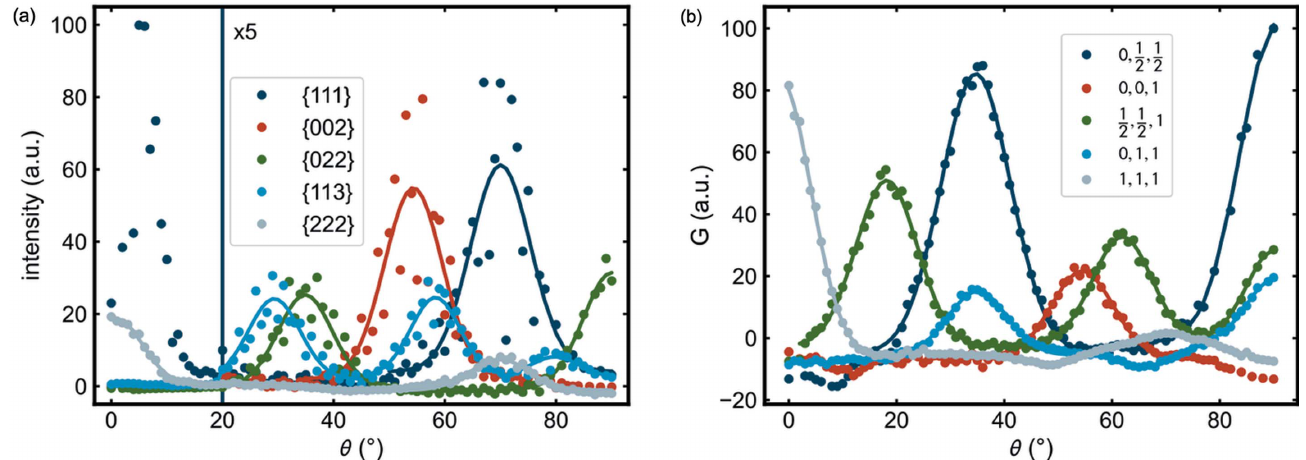
Figure 8 ( a ) Reciprocal-space fiber plots of the first five X-ray diffraction reflections. ( b ) Real-space fiber plots of the first five PDF peaks. Gaussian fits of the peaks in the fiber plots are shown as solid traces. The fit of the reciprocal 111 reflection at (cid:5) = 0 (cid:3) is omitted because of low data quality at that region and poor resolution at low Q after the conversion to polar coordinates. The fit of the real 111 peak at (cid:5) = 70.53 (cid:3) is omitted because of a poor fit result due to the low intensity. The intensities of the reciprocal- and real-space fiber plots were retrieved by summing over all intensity values at the H hkl value of the respective peak (cid:9) 0.1 A˚ (cid:4) 1 from the scattering volume S ( Q ) and over the r ij values of the respective interatomic distance (cid:9) 0.1 A˚ from the txPDF G ( r ), respectively. Increasing the integration width for the fiber-plot construction does not reduce the high noise in the reciprocal-space fiber plot. All intensities beyond the vertical line at (cid:5) = 20 (cid:3) in ( a ) are multiplied by 5 since intensity values at high (cid:5) are hardly visible if put on the same scale as the high intensities at low (cid:5)